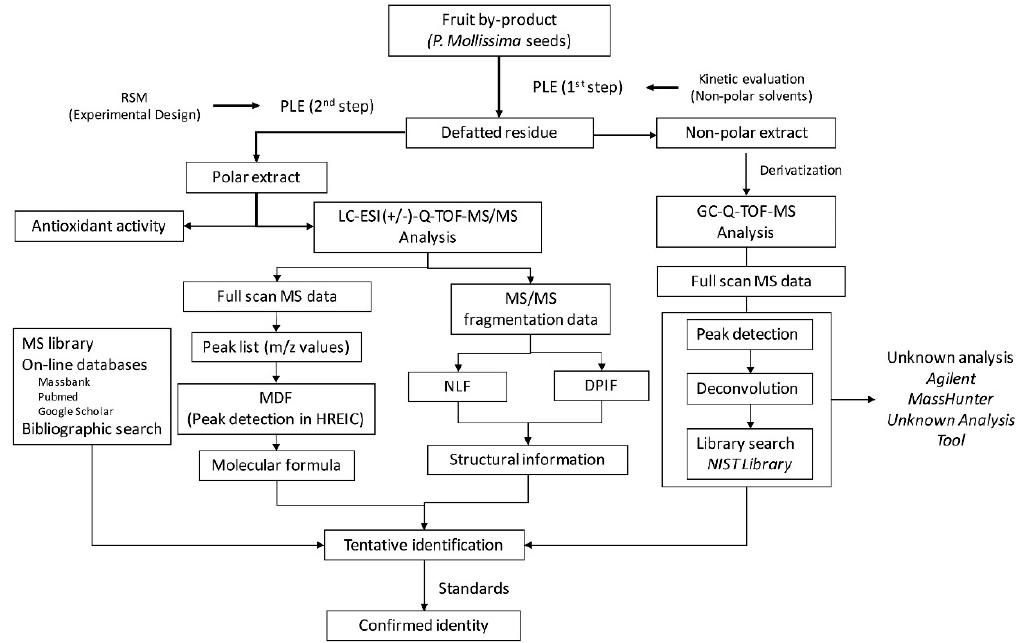
Figure 8. Workflow of the detailed chemical characterization of the bioactive components from Passiflora mollissima seeds. Legend: MDF: mass defect filtering; DPIF: diagnostic product ions filtering; HREIC: high-resolution extracted ion chromatograms; NLF: neutral loss filtering; PLE: pressurized liquid extraction; RSM: response surface methodology. Reprinted from [99].